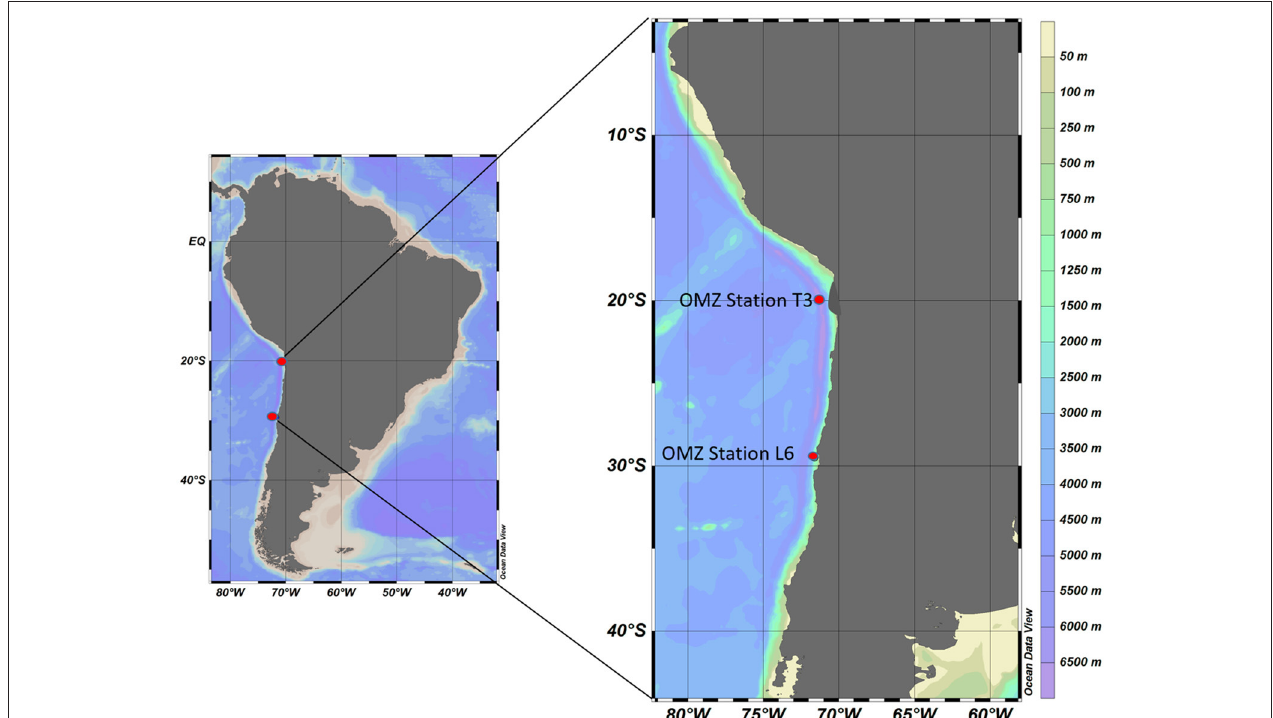
FIGURE 1 | Location of sampling and MS-SID deployment sites in the ETSP OMZ off the northern coast of Chile.